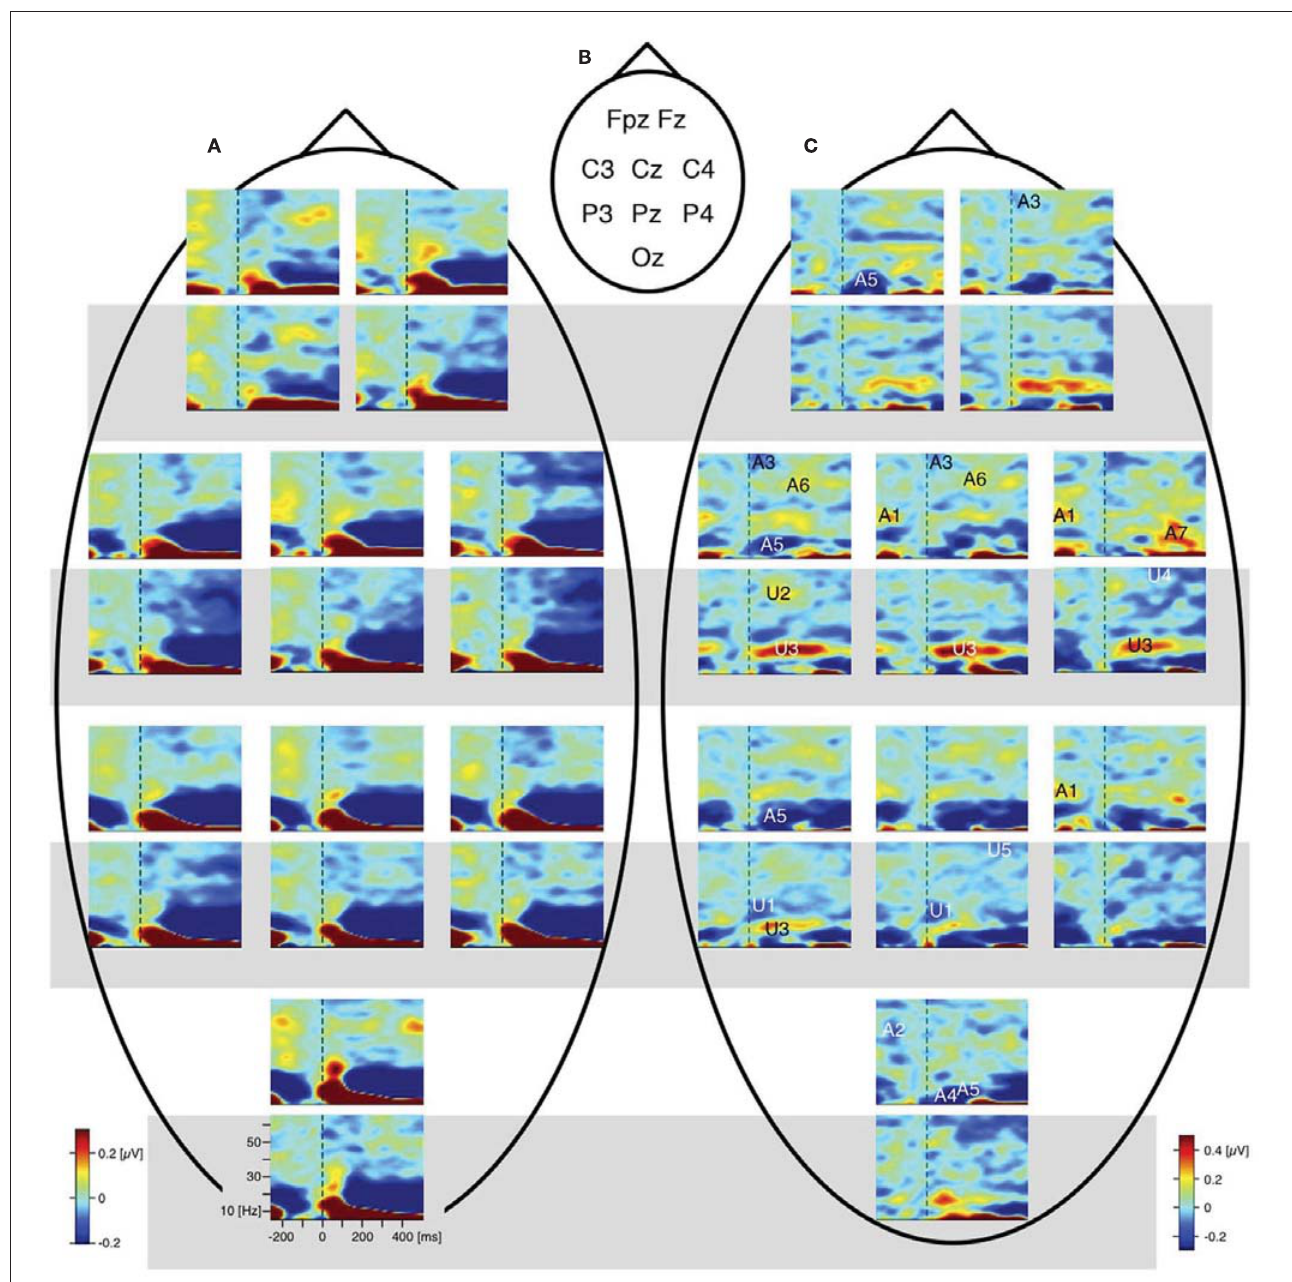
charts (reversal minus stability). Entries in (B) (e.g., A1, U2, ... ) indicate the position of significant deflections from zero in the time–frequency plane. A, ambiguous; U, unambiguous; numbers indicate the temporal order of effects; black/white colouring of the numbers and letters is only for saliency. Most remarkable is the gamma band modulation before onset of the ambiguous Necker stimulus (deflection A1 at electrodes P4 and C4 and Cz; and deflection A2 at electrode Oz). No such modulation occurs with the unambiguous stimulus variants. (from Ehm et al., 2011, Figure 2